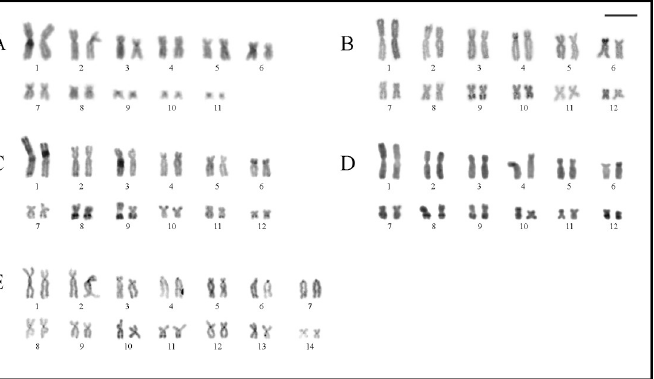
Fig 4. C-banded karyotypes of Phyllodytes and Osteocephalus . A. Phyllodytes edelmoi . B. Osteocephalus taurinus . C. O . oophagus . D. O . leprieurii . E. O . buckleyi .